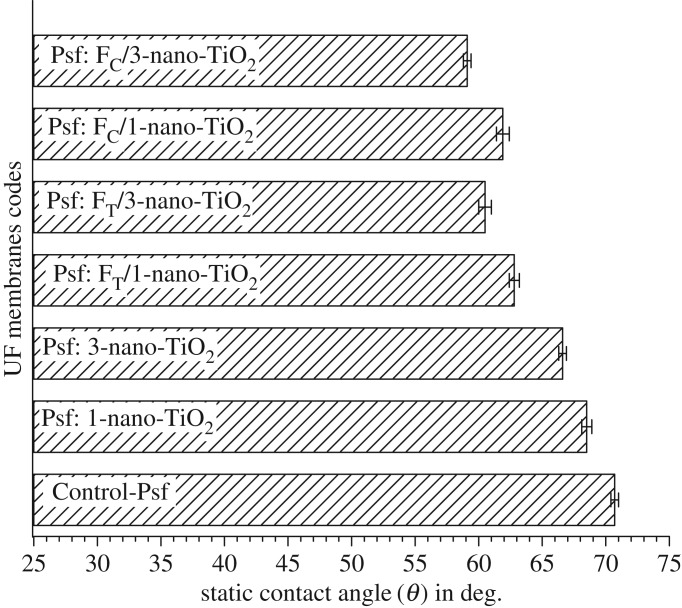
Hydrophilic characters of membranes: Control-Psf UF, Psf: nano-TiO2 UF, Psf: FT-nano-TiO2 UF and Psf: FC-nano-TiO2 UF.